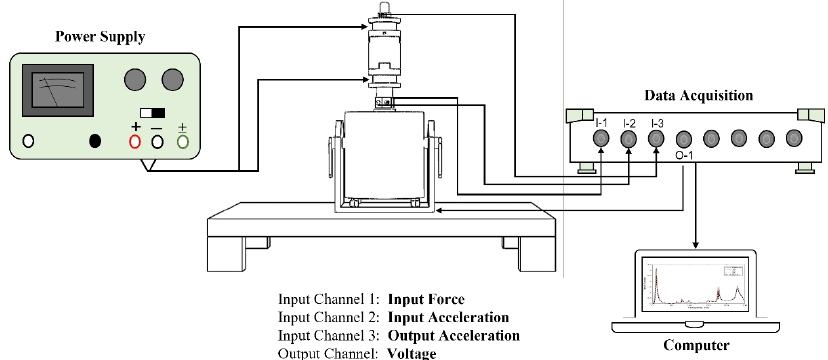
Figure 7. Schematic representation of the experimental setup.